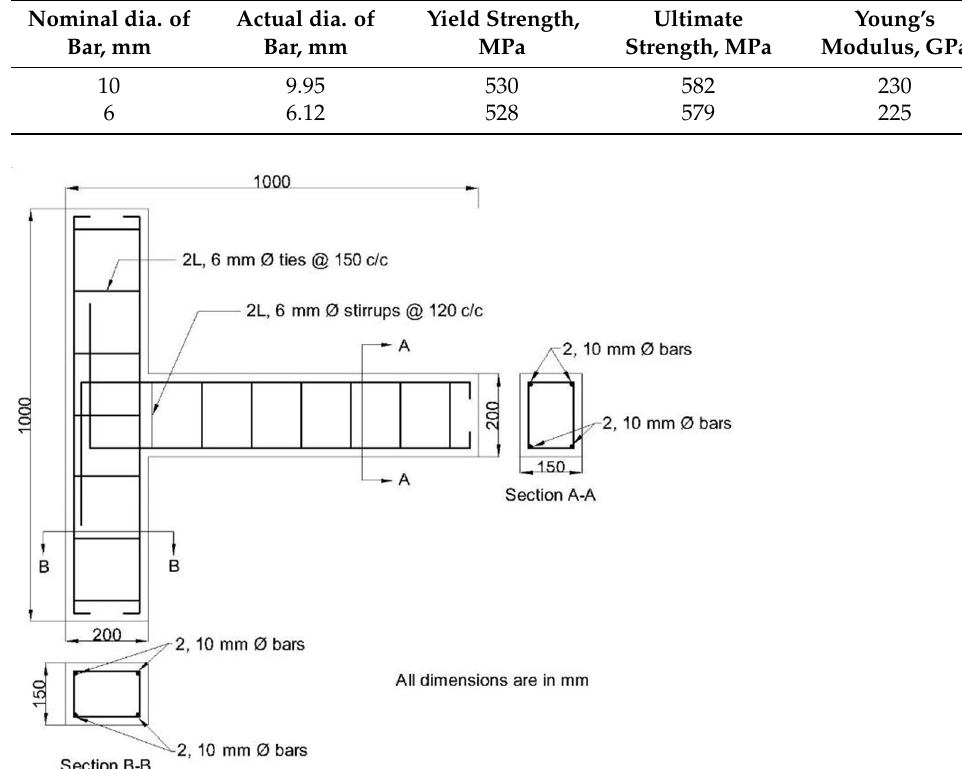
Table 2. Properties of reinforcing bars.